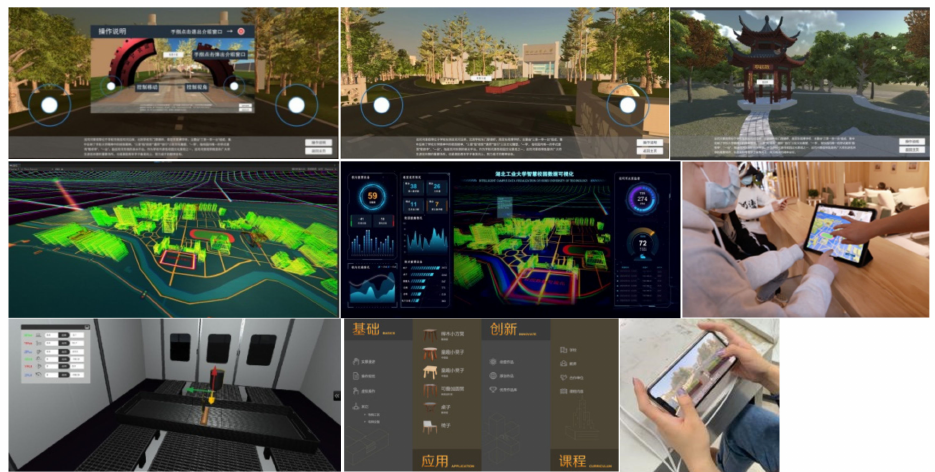
Figure 17. Functions of the smart campus system and user experience.